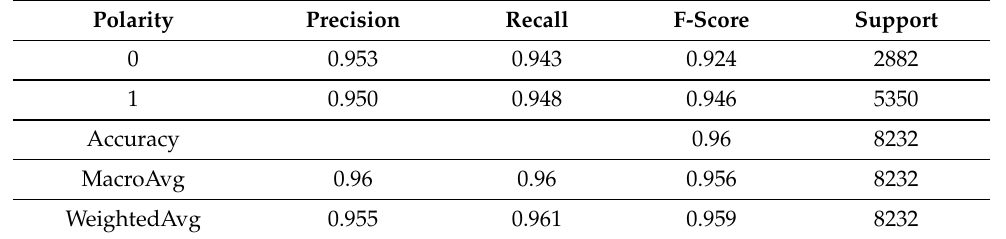
CUDA-SADBM Classifier for multiclass classification. Training accuracy